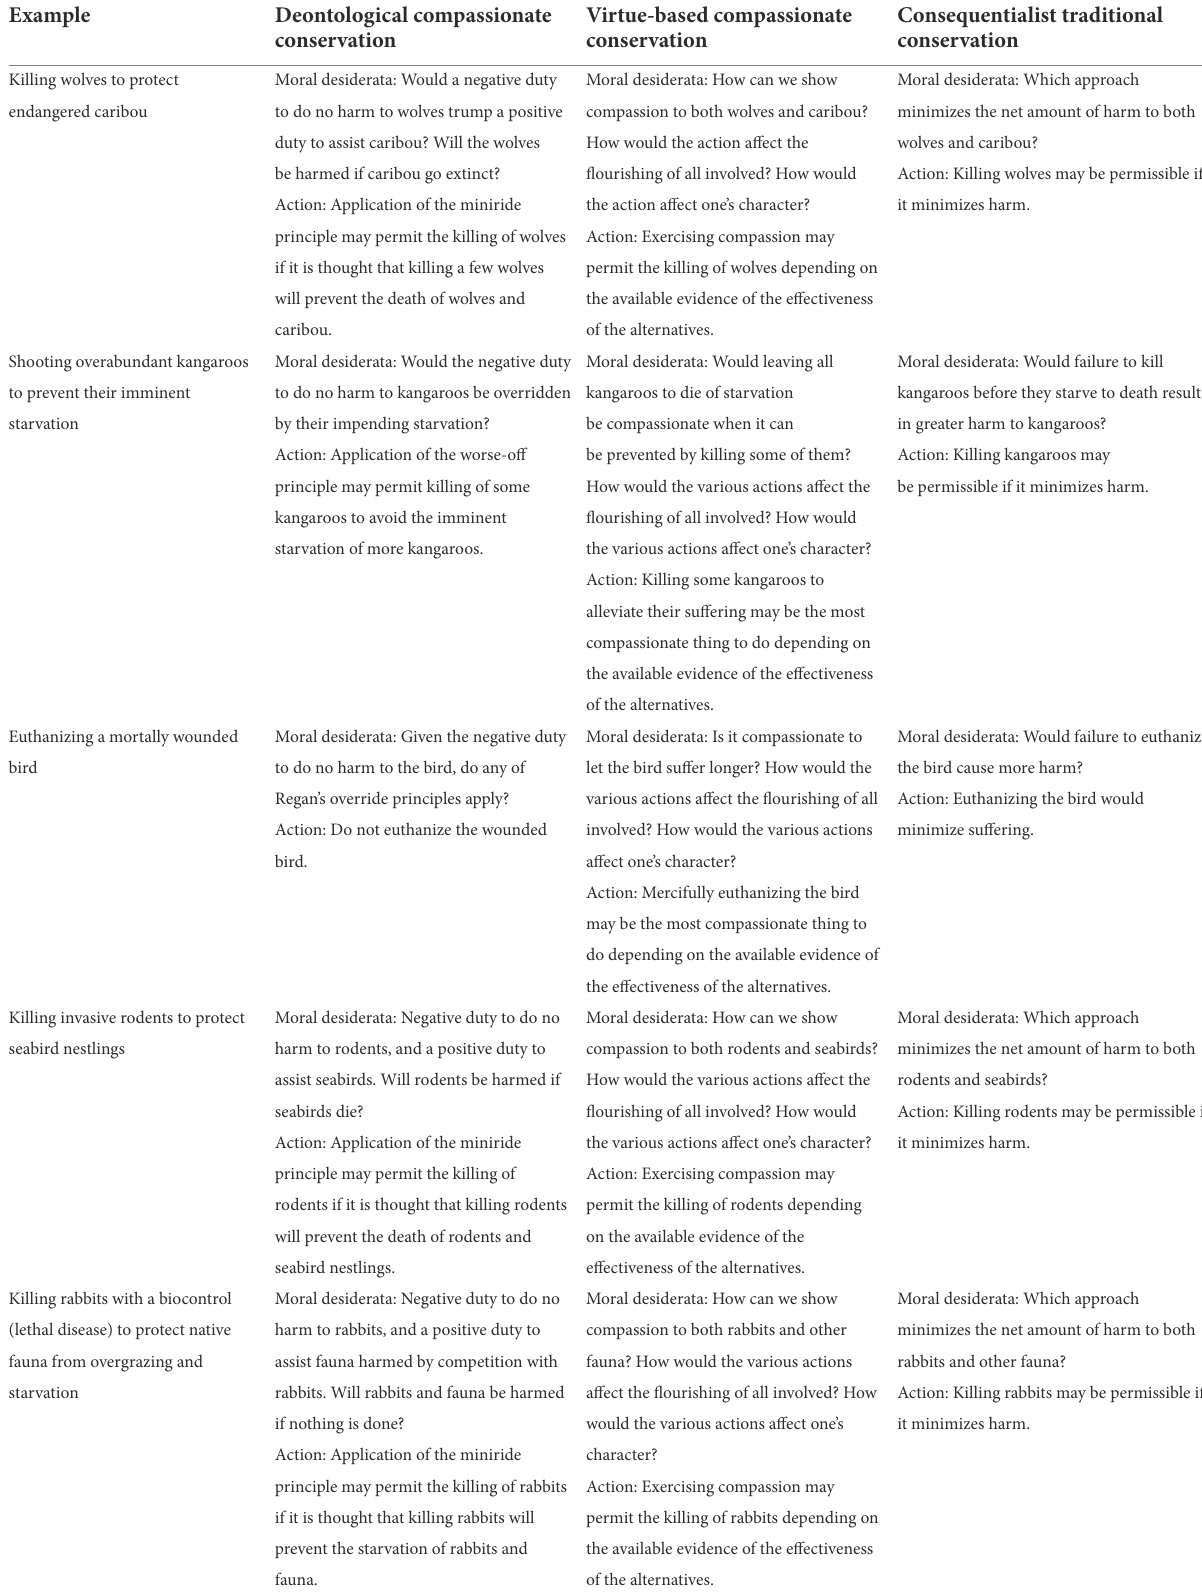
TABLE 1 Examples of some emblematic conservation problems and how they might be approached from the perspectives of a deontological compassionate conservationist, a virtue-based compassionate conservationist, and consequentialist traditional